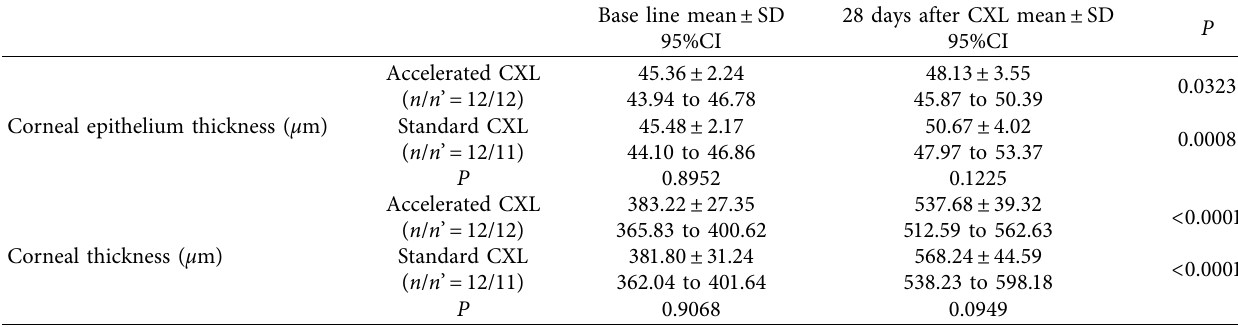
Table 1: Corneal and corneal epithelium thickness between